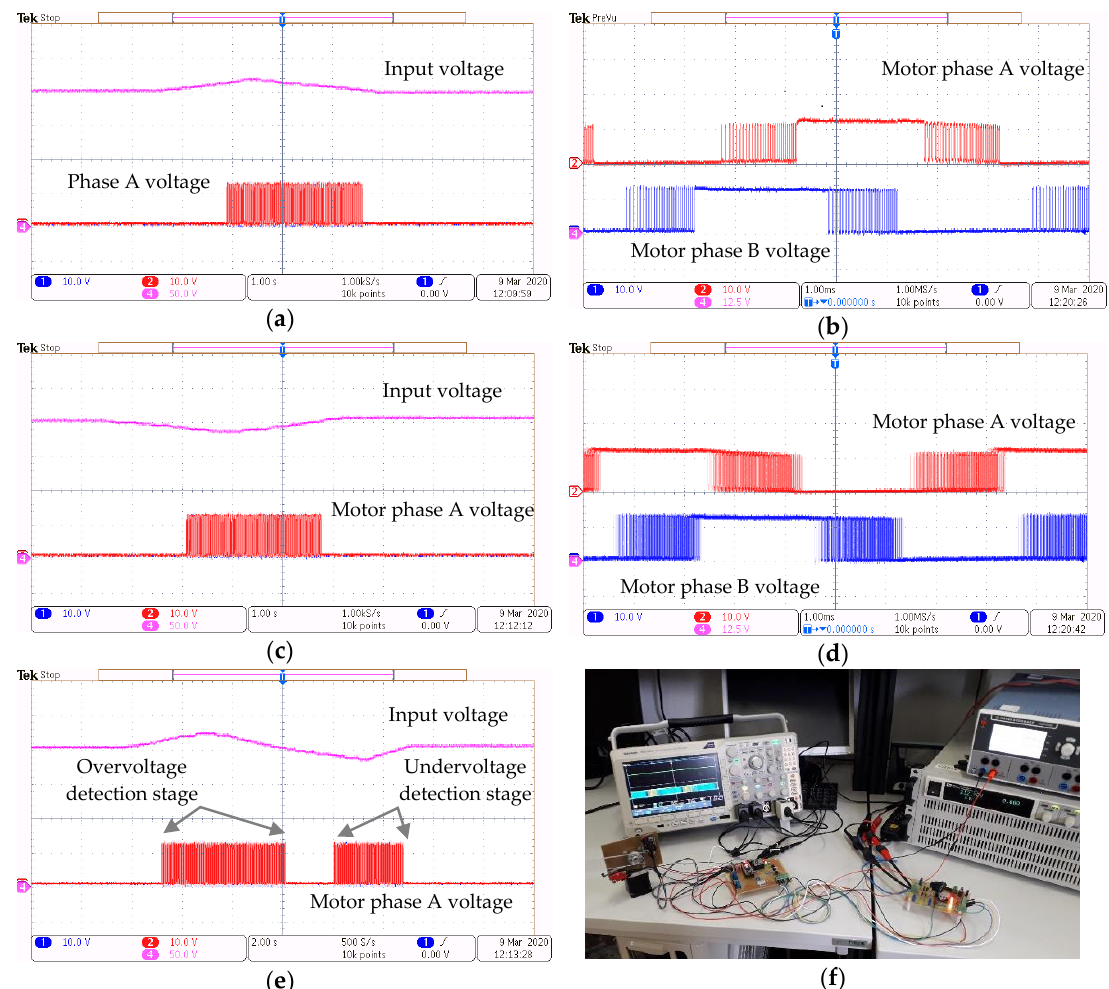
Figure 14. Working principle waveforms of the stepper motor angular command: ( a ) overvoltage transistor command signal, ( b ) voltages of the motor phases in the overvoltage detection, ( c ) undervoltage transistor command signal, ( d ) voltages of the motor phases in the undervoltage detection, ( e ) overvoltage and undervoltage commands, and ( f ) laboratory test setup.